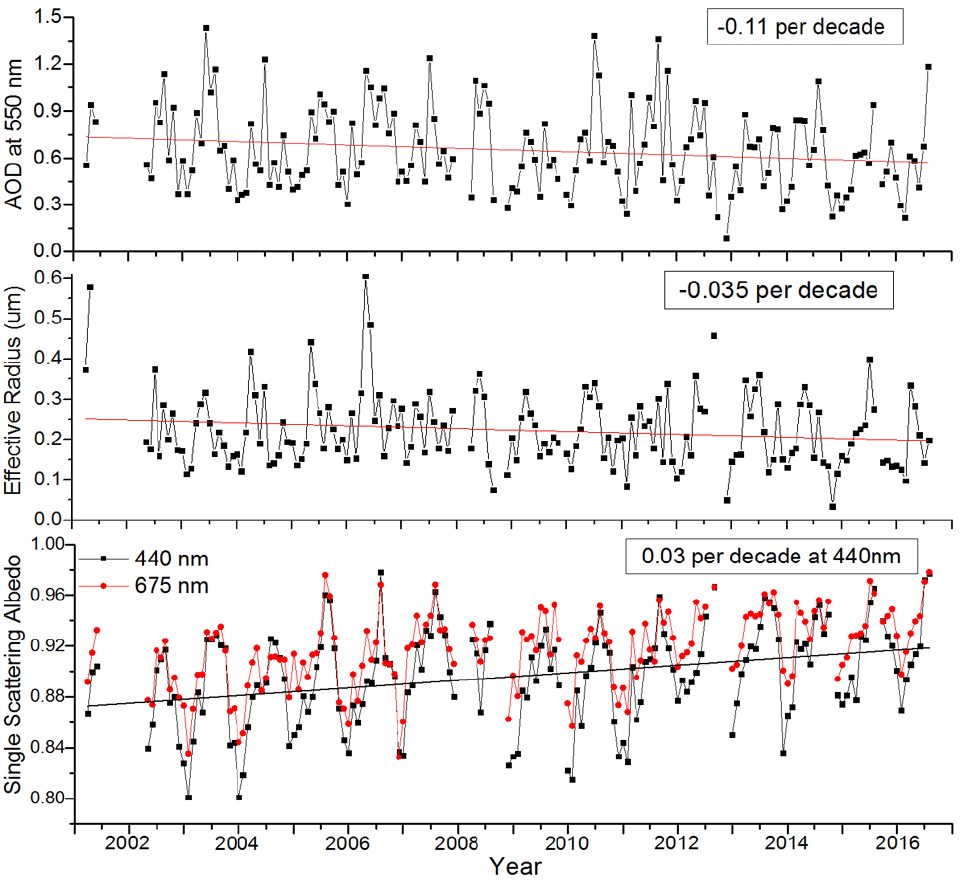
Figure 9. Variations of monthly AOD at 550 nm, total effective radius, and single scattering albedo in Beijing from 2001 to 2016.